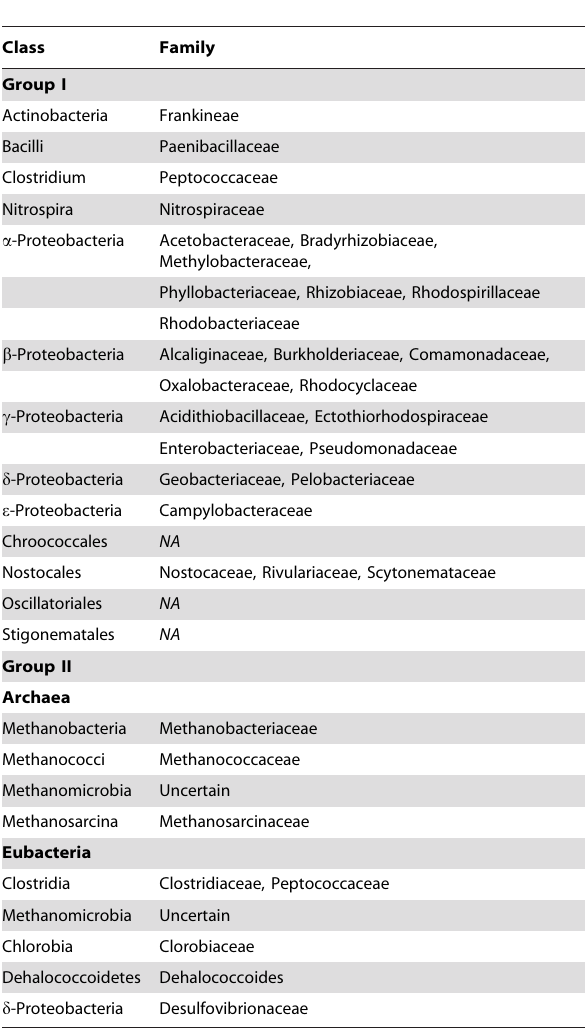
Table 3. Lineages of Archaea and Bacteria with the NifD sequences listed in Tables 1 and